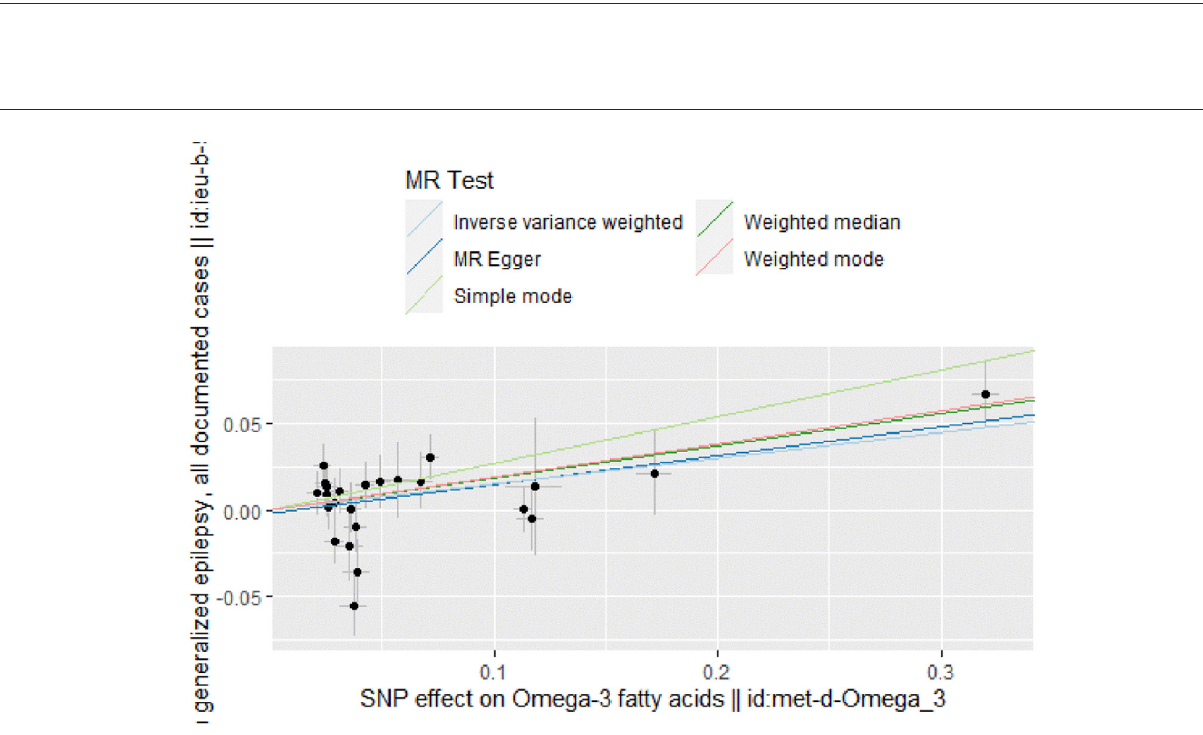
FIGURE3 Scatter plot of MR analysis of the causal relationship between omega-3 fatty acids and generalized epilepsy, the beta value represents the slope of the graph; The regression line for MR-Egger, weighted median, IVW, simple mode, and weighted mode is